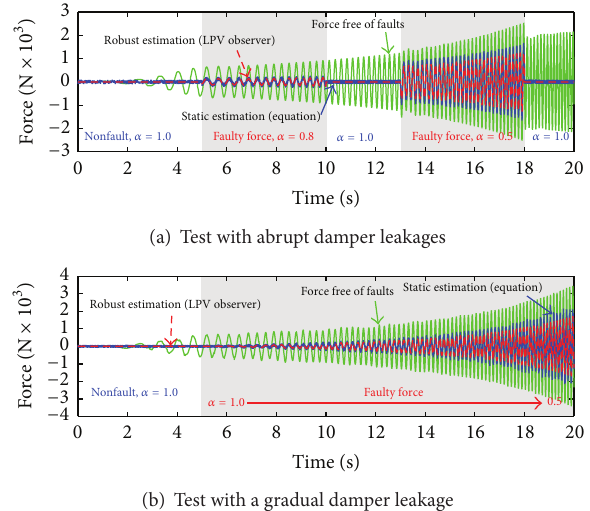
Figure 7: Fault estimation performance with the LPV/ 𝐻 ∞ observer.